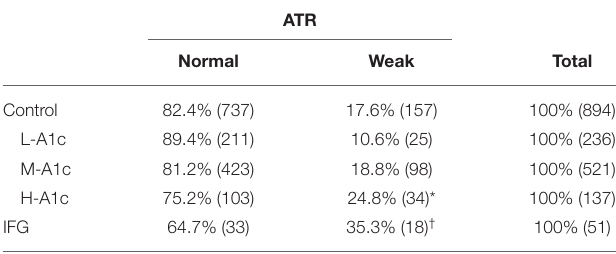
TABLE 5 | Correlation of normal high HbA1c and IFG with decreased ATR. ATR Normal Weak Total